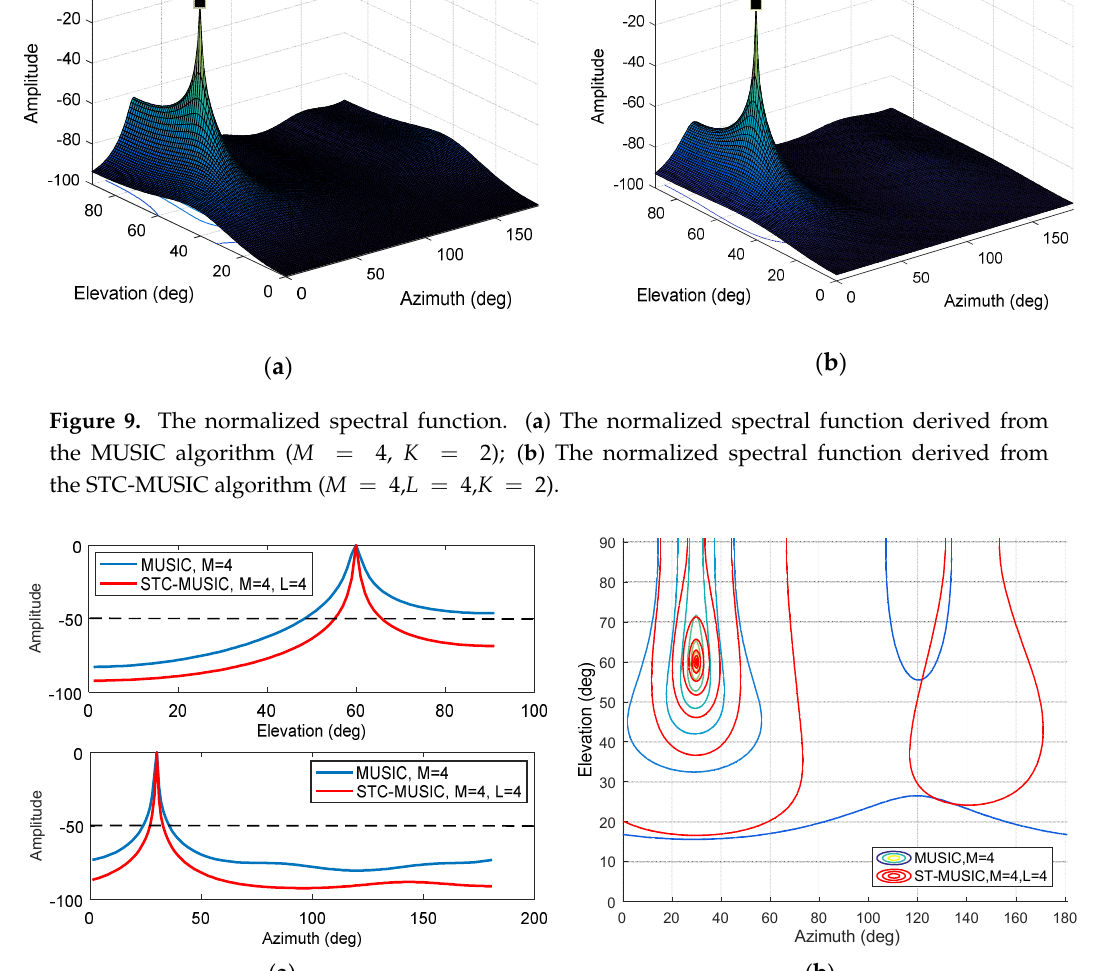
( b ) Figure 11. ( a ) The normalized spectral function derived from the MUSIC algorithm ( 4 M  ,  3 K ); ( b ) The normalized spectral function derived from the STC-MUSIC algorithm ( 4 M  , 4 L  , 8 K  ).